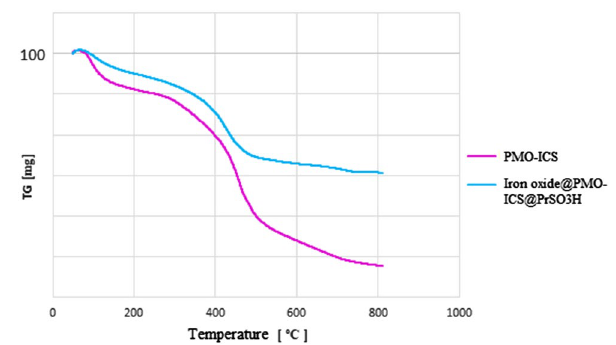
Figure 3. TGA analysis of pure PMO-ICS (purple curve) and Iron oxide@PMO-ICS-PrSO 3 H mesoporous catalysts ( 1 , blue curve).